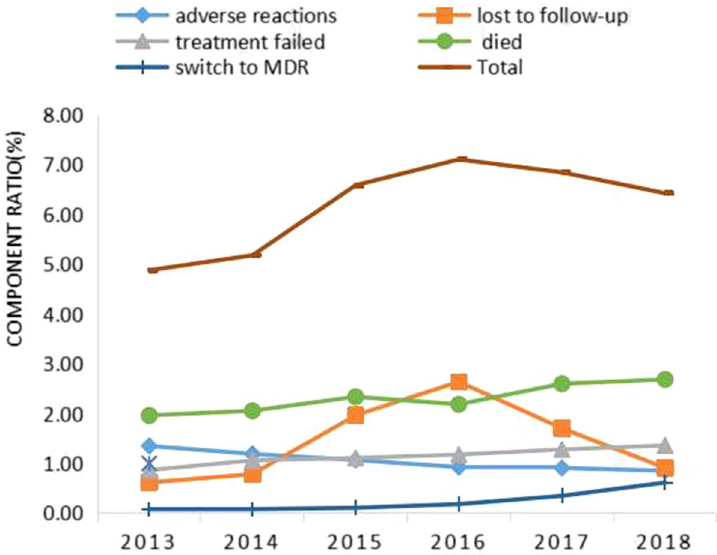
Figure 2. Variation trends ( p < 0.05) of the component ratio (CR) of adverse outcomes in TB Patients (%), Guizhou, China,